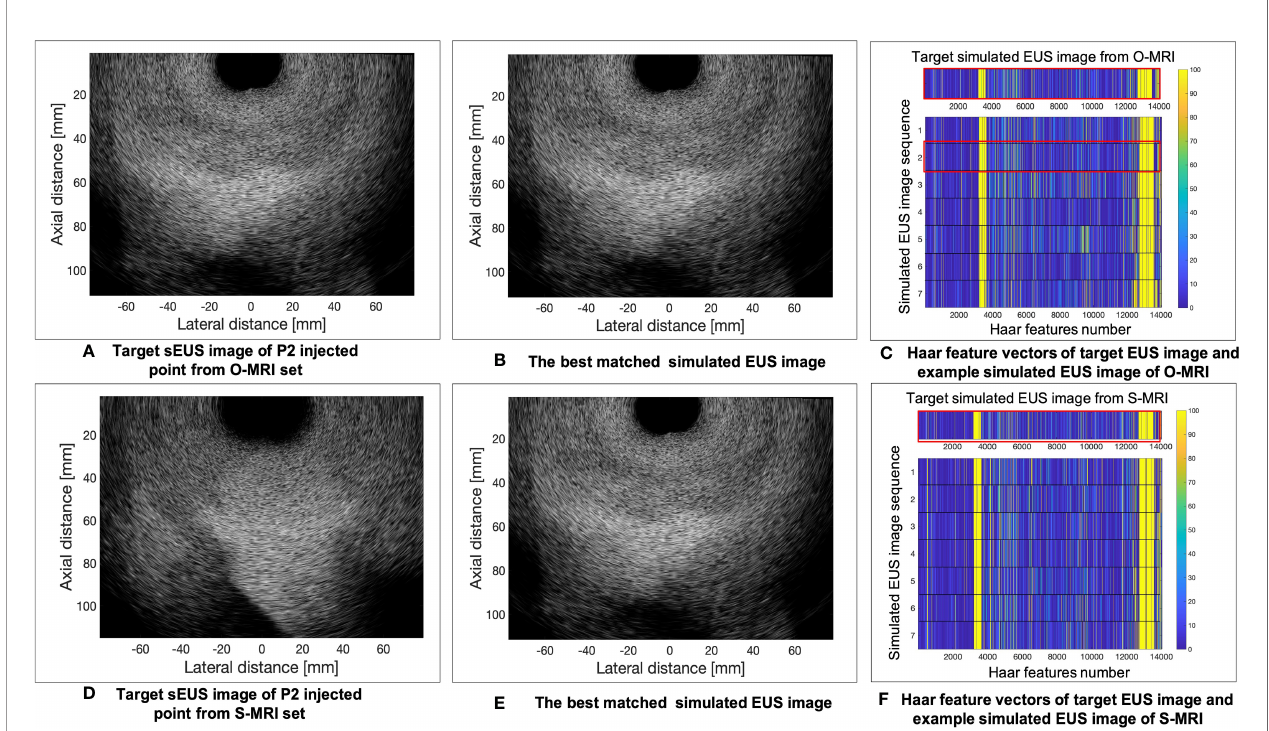
FIGURE 9 | The example results of the MRI patient experiment. (A) shows the target simulated EUS image which was chosen from O-MRI simulated EUS image set at the P2 simulated injected point with . B1 – 15° interpolated direction. (D) shows the target simulated US image from S-MRI at the same position. (B, E) show the corresponding best matched simulated EUS images found in the O-MRI simulated EUS set. (C, F) show the Haar feature vectors comparison between target EUS images and simulated EUS images from the same potential injected points. The Haar feature vectors of the target EUS image and corresponding best matched simulated EUS image was in the red